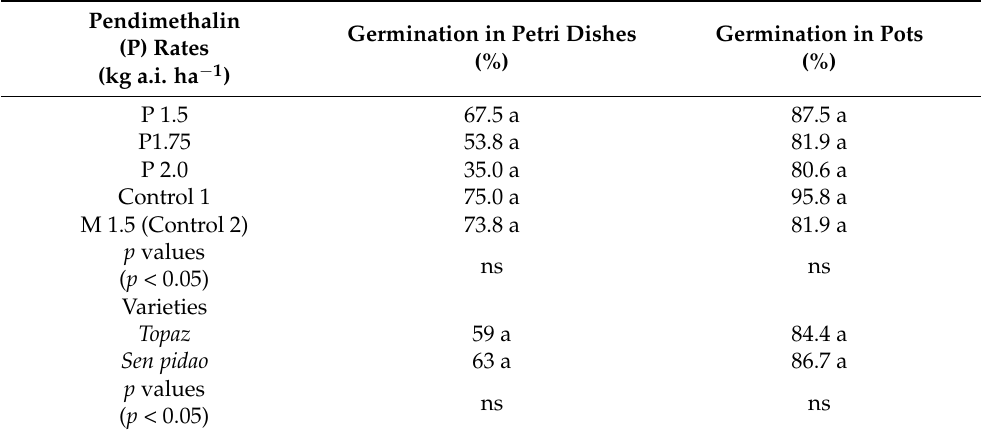
Table 2. Effects of pre-emergence herbicides and varieties in rice germination under different growing conditions for the direct sowing method.